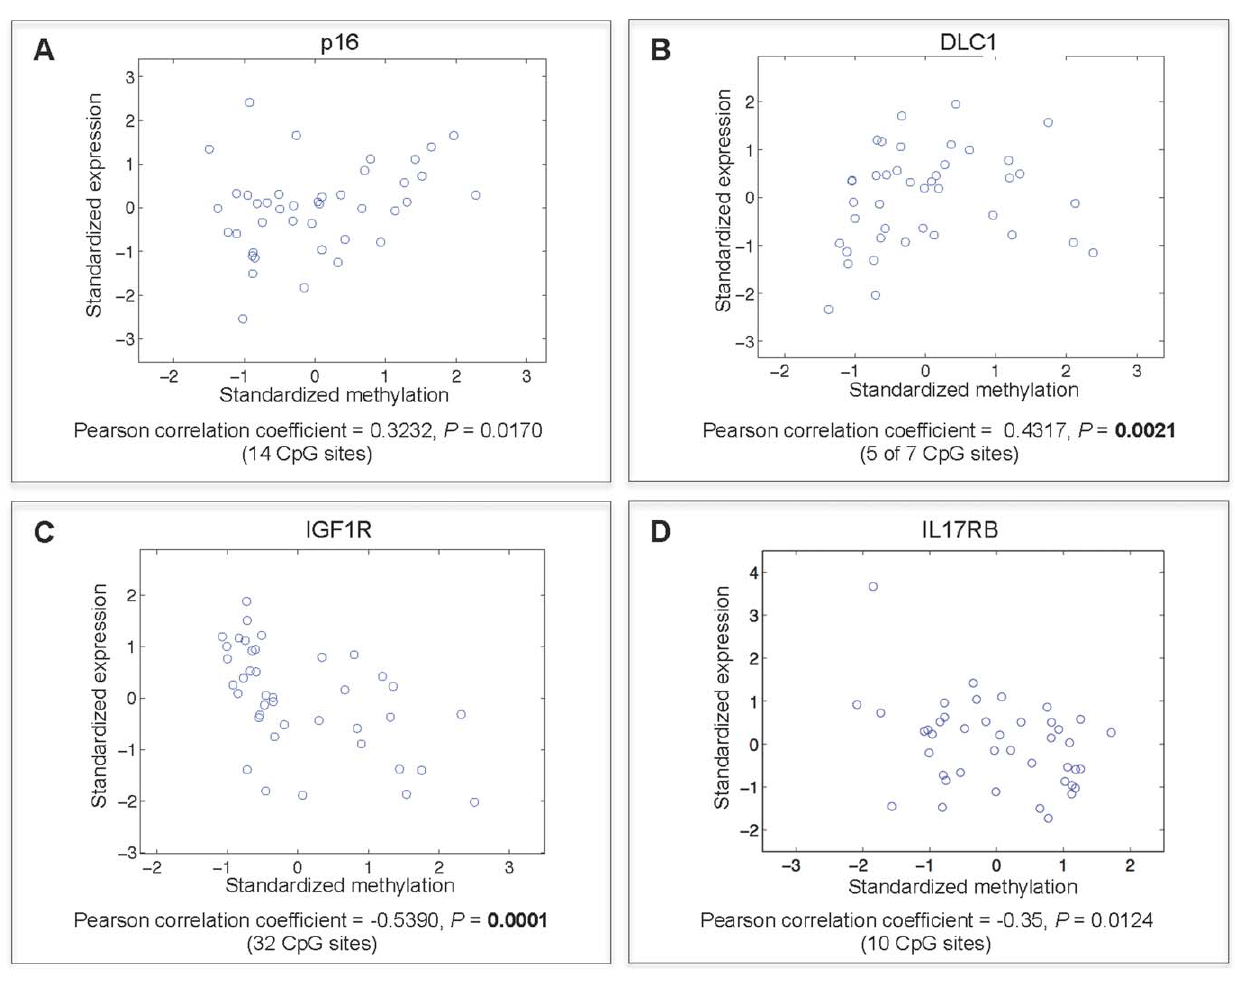
Figure 5. Validation of methylation-expression relationships by Pearson correlation for p16, DLC1, IGF1R and IL17RB using pyrosequencing and qRT-PCR in an independent sample set. Scatter plots depict the extent of linear correlation of DNA methylation (x axis) to gene expression (y axis) for p16 (A), DLC1 (B), IGF1R (C), IL17RB (D) in 43 MM samples. Methylation data was generated by bisulfite pyrosequencing and the average percent methylation for all CpG loci interrogated is shown. Gene expression relative fold-change was obtained by qRT-PCR. Pearson correlation coefficients are shown and P values are generated by random permutation tests.